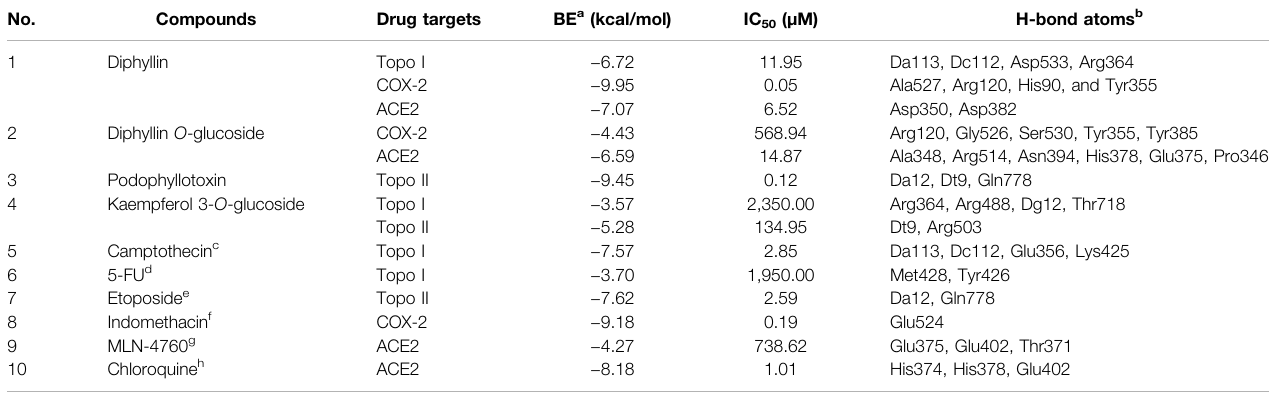
TABLE 3 | The molecular docking results of potential bioactive ligands screened from P. sinense and positive drugs against Topo I, Topo II, COX-2 and ACE2.